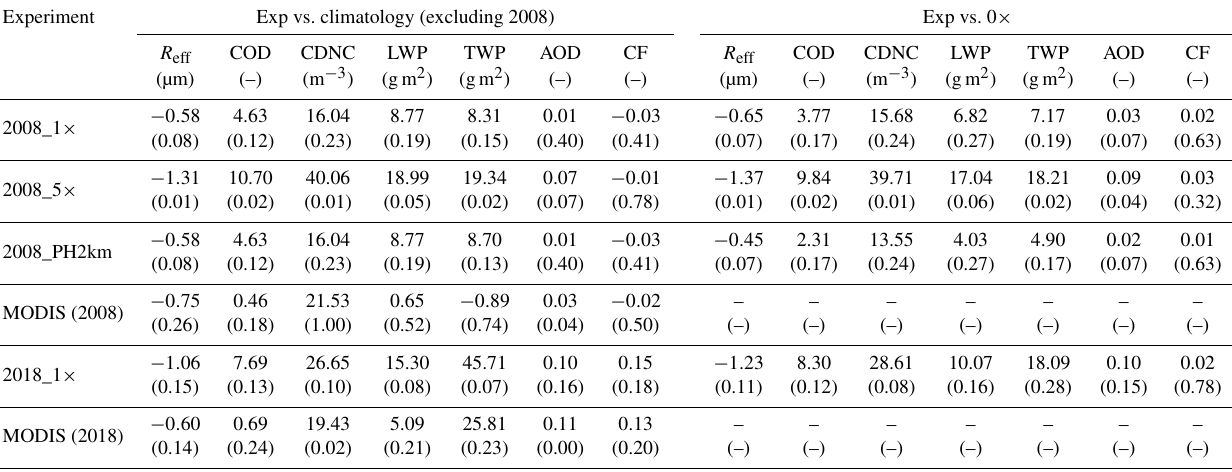
Table 3. Anomalies for liquid cloud properties, AOD, and CF. Values in parentheses are the p values associated with a one-sided Student’s t test against the long-term mean.